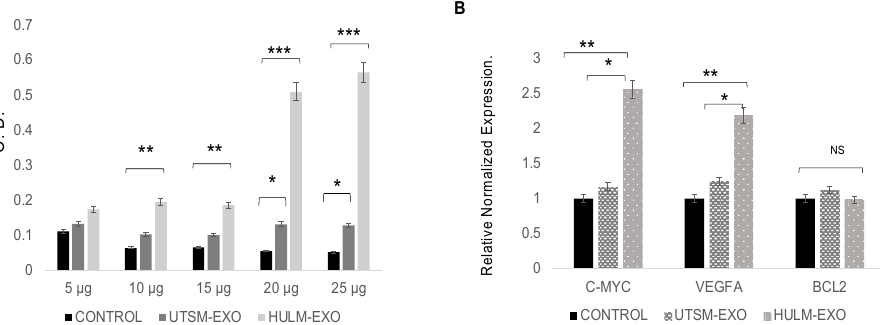
Figure 3. Treatment with human uterine leiomyoma-derived exosomes increases cell proliferation on HEMEC. ( A ) HEMEC cells were treated with 5, 10, 15, 20, and 25 ug/mL of HULM-EXO, UTSM- EXO, or PBS as negative control for 48 h. Then, BrdU incorporation assay was performed to measure cell proliferation. There is significant increase in cell proliferation on HEMEC cells treated at 20 and 25 ug/mL in HULM-EXO compared to UTSM-EXO or PBS treated groups. ( B ) mRNA quantification, HEMEC cells were treated with 25 ug/mL of HULM-EXO, UTSM-EXO, or PBS, followed by qRT- PCR to check for the proliferation marker: C-MYC, the angiogenic marker VEGFA and the apoptosis marker BCL2. C-MYC and VEGFA mRNA levels were upregulated on HEMEC cells treated with HULM-EXO compared to cells treated with UTSM-EXO or PBS (* p < 0.05), while no changed was observed in BCL2 expression. Values were statistically significant when p was <0.05. (** p < 0.01, *** p < 0.001), NS: not significant. 2.4. Exosomes from Human Uterine Leiomyoma Cell Line Cocultured with HEMEC Demonstrate Angiogenic Properties To further examine the effects of exosomes derived from leiomyoma cell line on the physiology of the endometrium, we cocultured HEMEC with HULM-EXO, UTSM-EXO, or PBS and monitored angiogenic markers (tube formation, length, and branching). HEMEC cells plated on Matrigel basement membrane matrix treated with HULM-EXO demonstrated greater tube formation (Figure 4A–C) and approximately 25% greater total tube length compared with cells treated with UTSM-EXO ( p < 0.05) or PBS (negative con- trol; Figure 4D). Nearly 40% increase in total branching points was also observed in HEMEC treated with HULM-EXO compared with those treated with UTSM-EXO ( p < 0.05) or PBS (Figure 4E). The greater tube formation, total tube length, and total branching points observed in HEMEC treated with HULM-EXO suggest that leiomyoma-derived exosomes, but not exosomes derived from healthy uterine tissue, exhibit pro-angiogenic properties, which might contribute to the abnormal menstrual bleeding observed in women with leiomyomas.